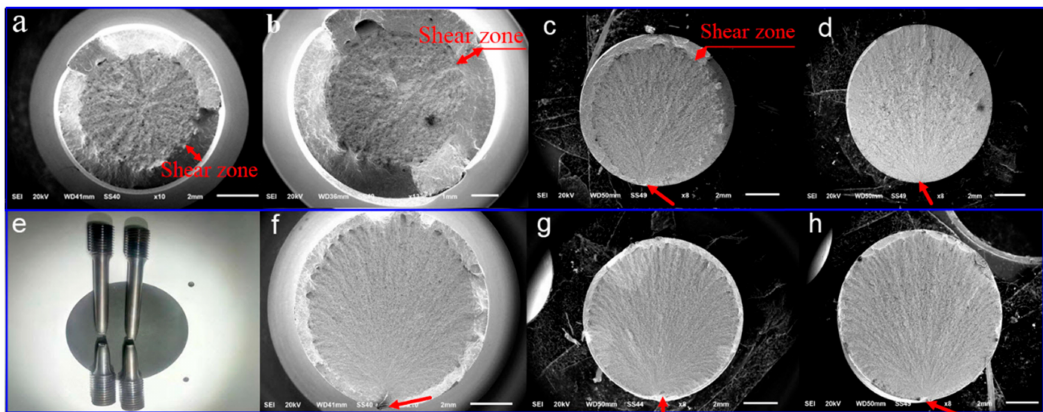
Figure 11. Macrographs for tensile fracture morphology of Inconel 783 alloy bolts that were as-initial ( a ), and aged at 650 ◦ C for 1000 h ( b ), 3000 h ( c ), 20,000 h ( d ), and 700 ◦ C for 1000 h ( f ), 3000 h ( g ), and 20,000 h ( h ), and samples after the tensile test ( e ).